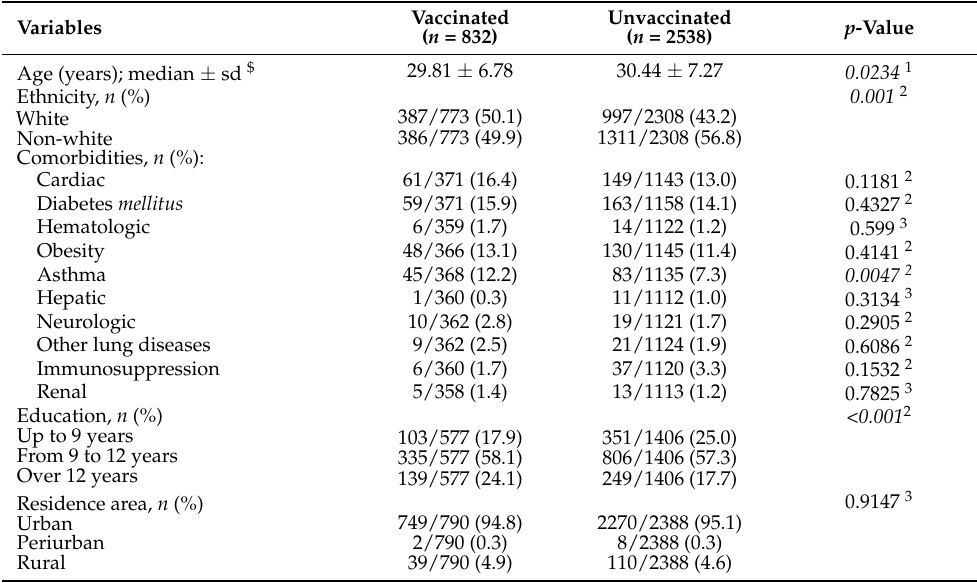
Table 1. Baseline characteristics of the subjects according to vaccination